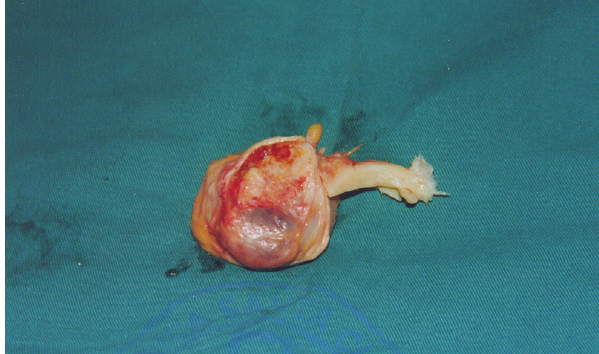
Figure 6 - Resected cyst with medial meniscus